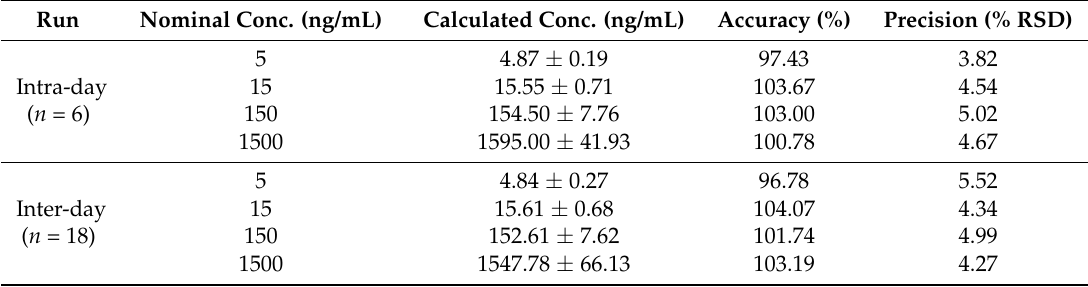
Table 1. Intra-day and inter-day accuracy and precision of kinsenoside in beagle dog plasma. Run Nominal Conc.